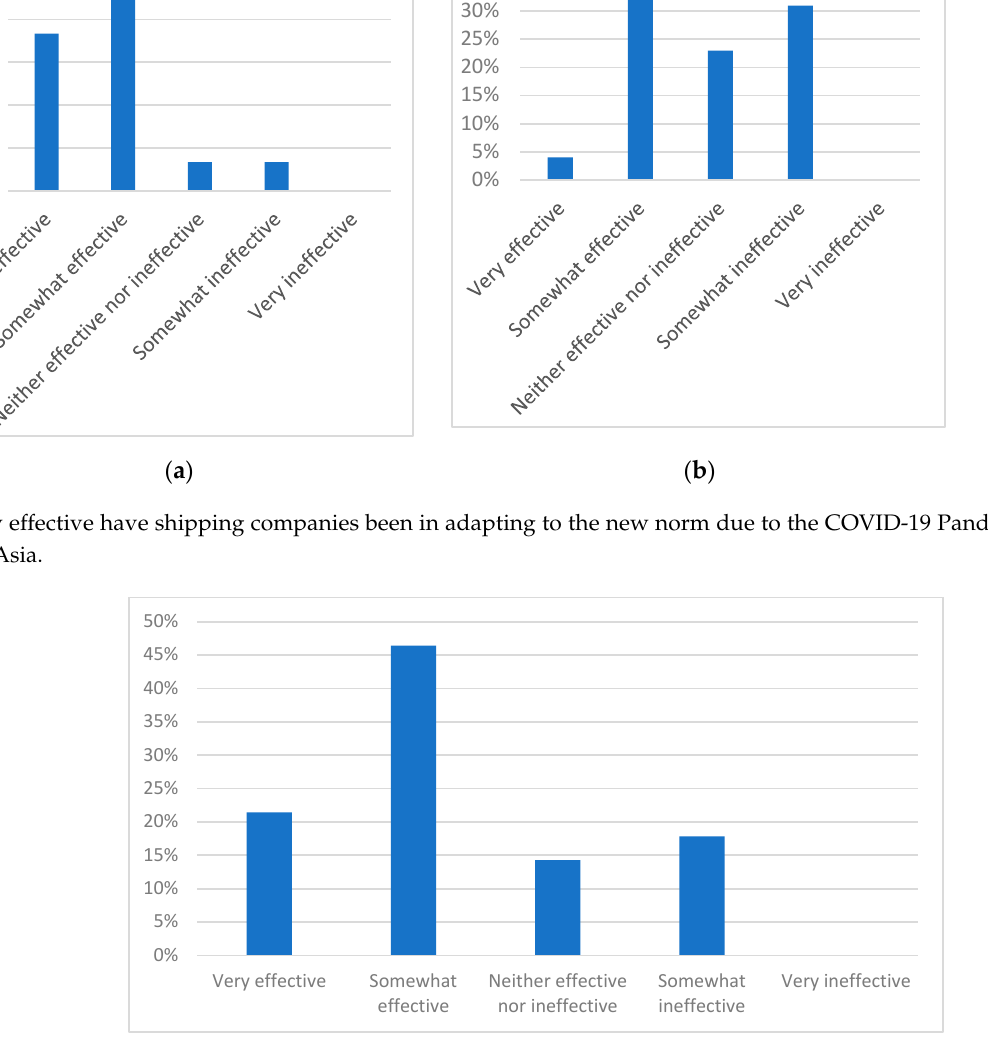
Figure 14. How effective have shipping companies been in adapting to the new norm due to the COVID-19 Pandemic? (Asia and Europe).